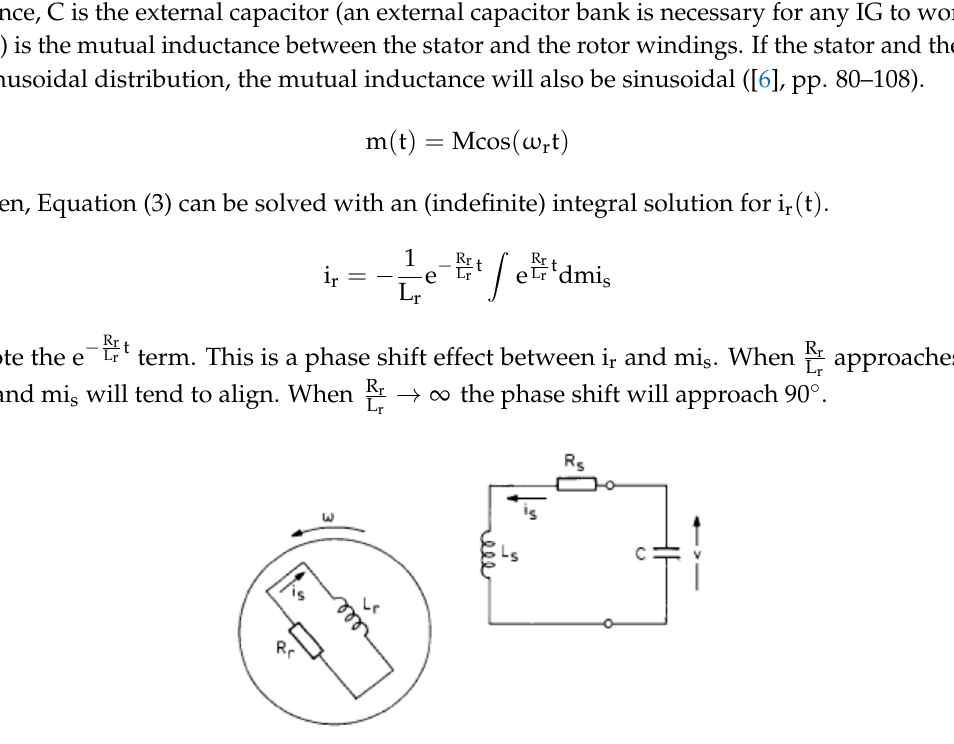
Figure 1. Circuit of the single-phase stator, single-phase rotor induction generator (IG).